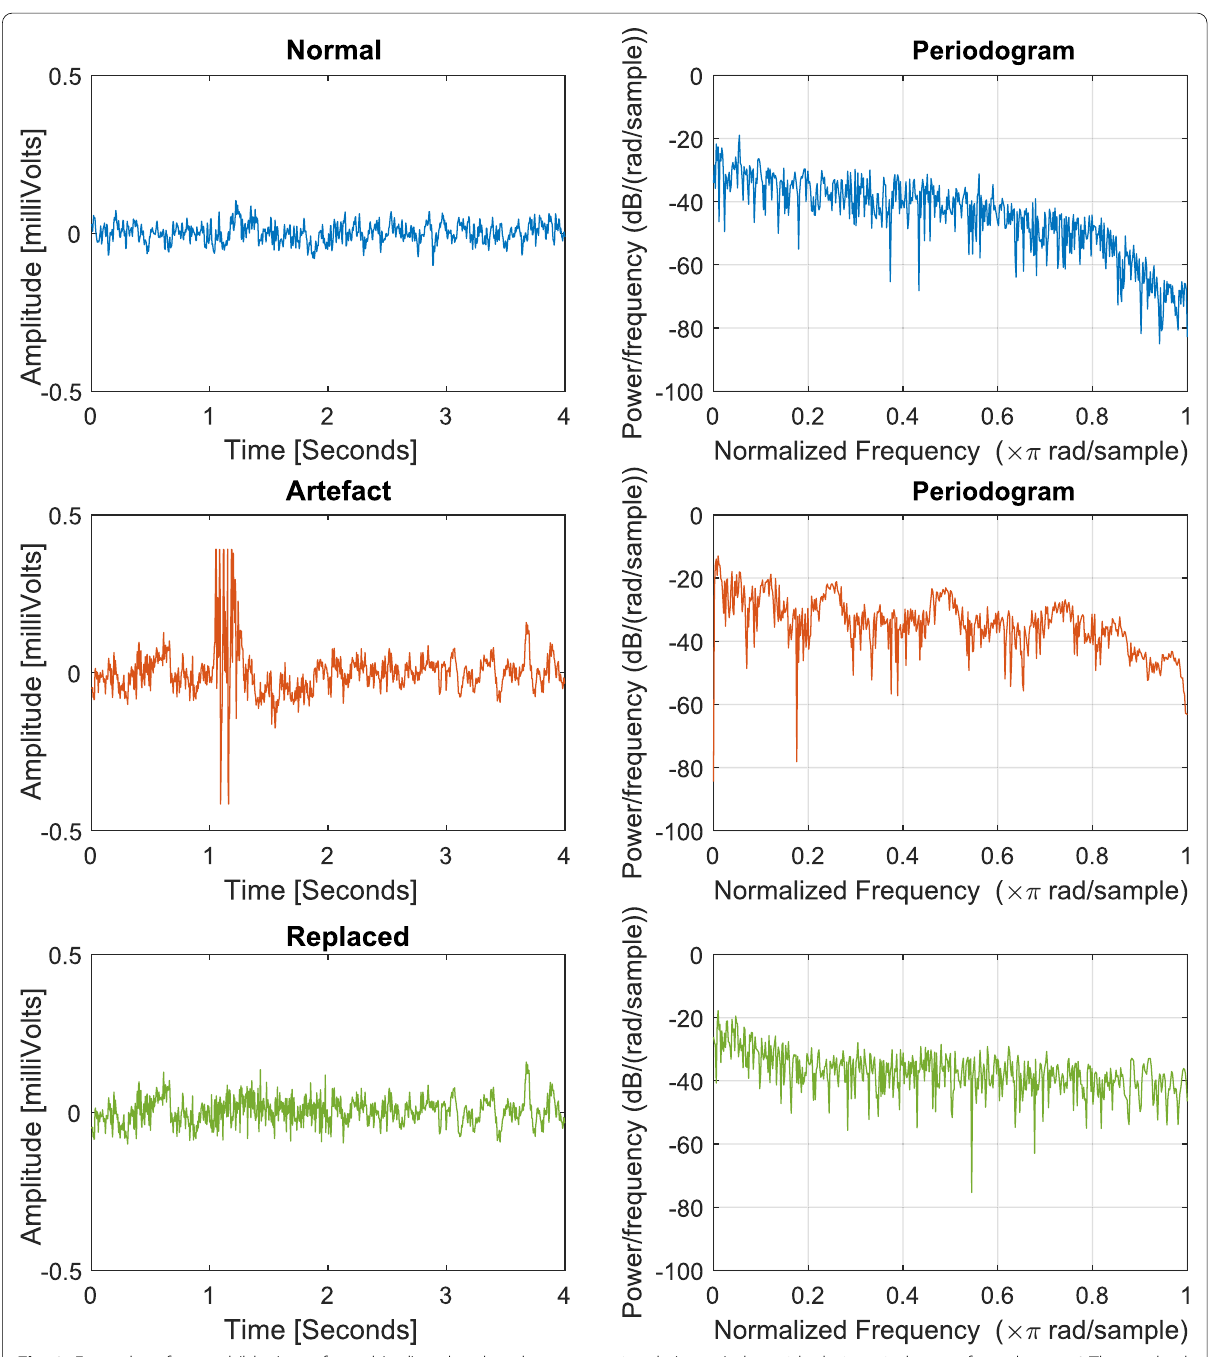
Fig. 9 Examples of normal (blue), artefactual (red) and replaced-segments signals (green) alongside their periodogram from data set 2.The method has been able to recreate the normal signal, both in amplitude as in spectral